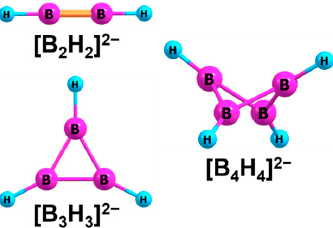
= 2–4). Lithium atoms are omitted for